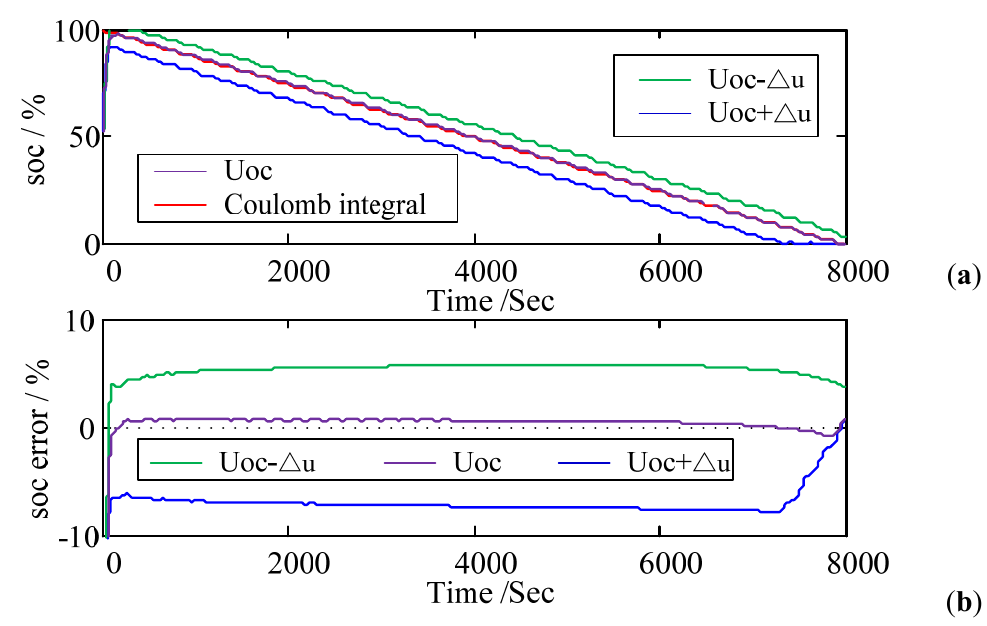
Figure 12. SOC estimation errors for adjusted SOC-OCV curves: ( a ) SOC estimation results; ( b ) SOC estimation